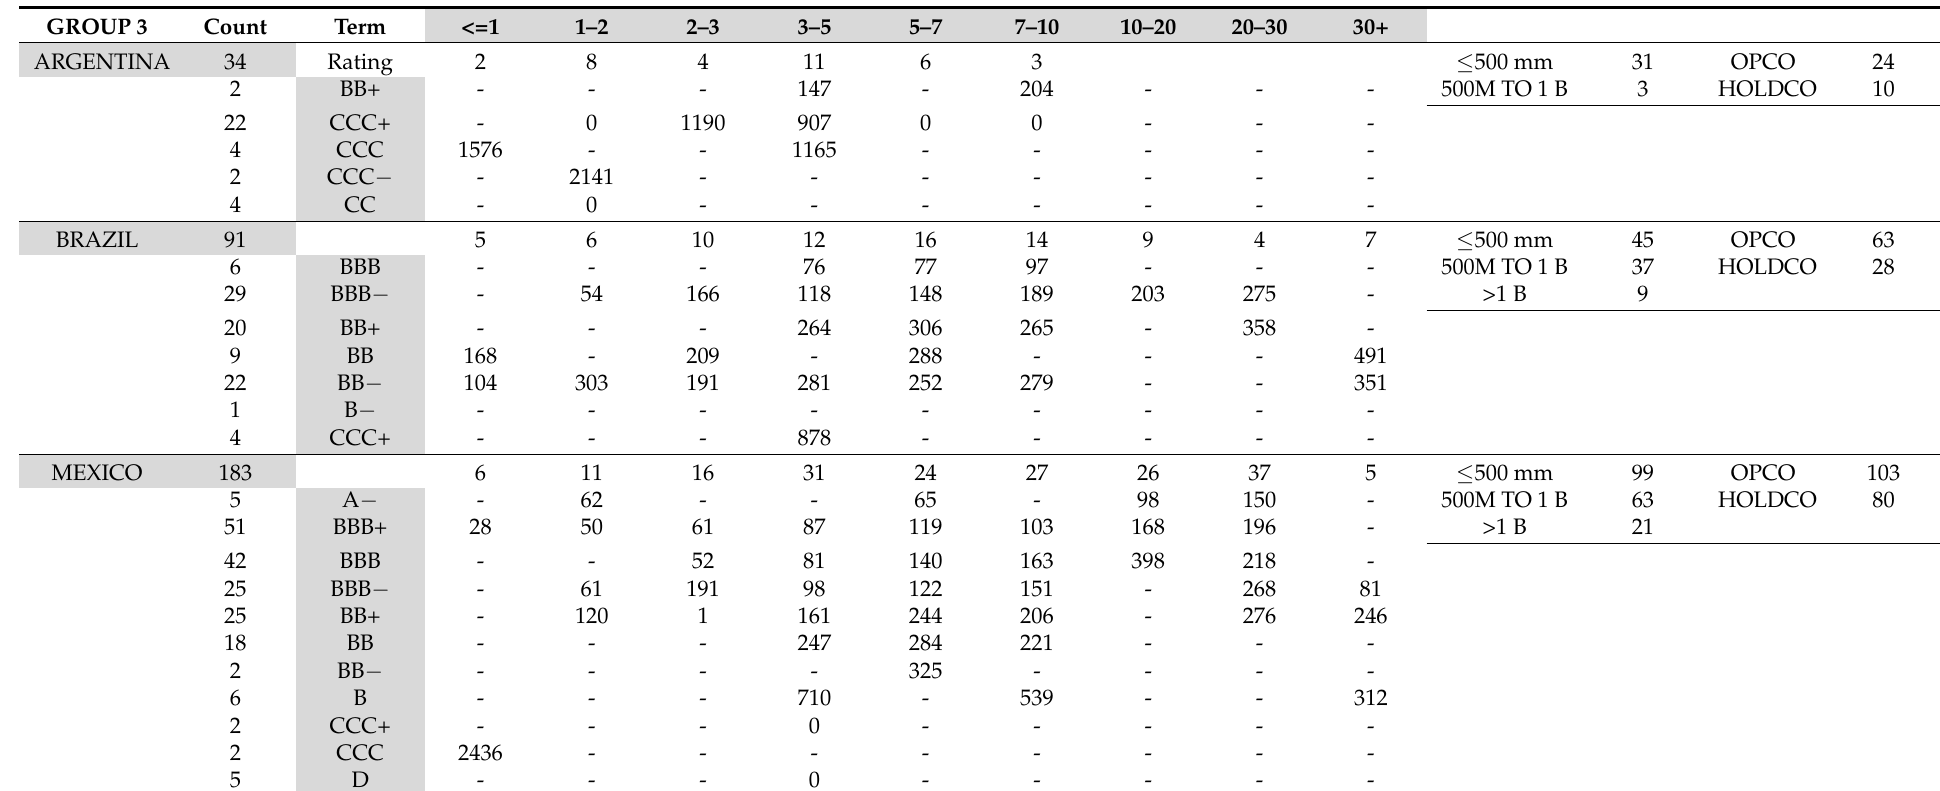
Table 5. G20—Group 3—Corporate credit spreads with S&P ratings and terms to maturity, issue amount, and the business structure of the issuer. Adding the spreads to the corresponding risk-free rate provides the expected return of the bonds. (Date: 16 August